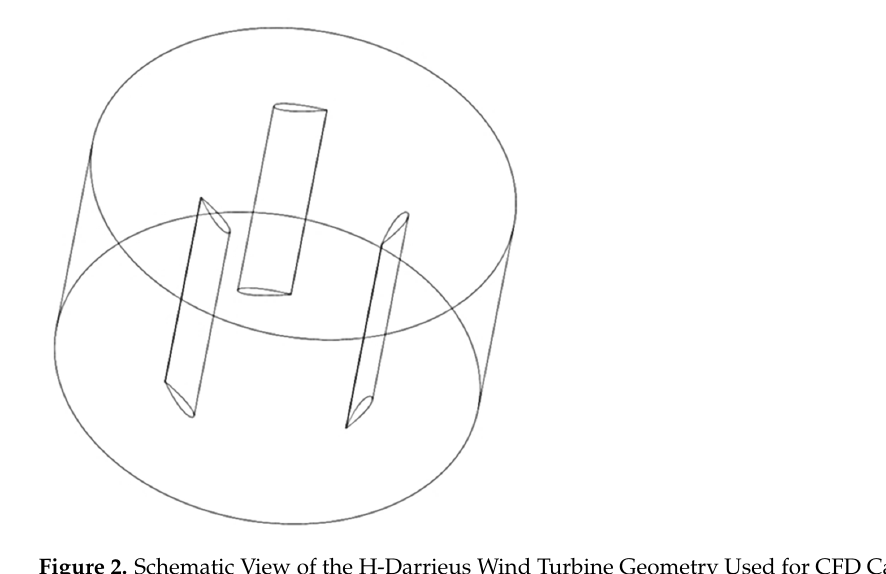
Figure 2. Schematic View of the H ‐ Darrieus Wind Turbine Geometry Used for CFD Calculations.